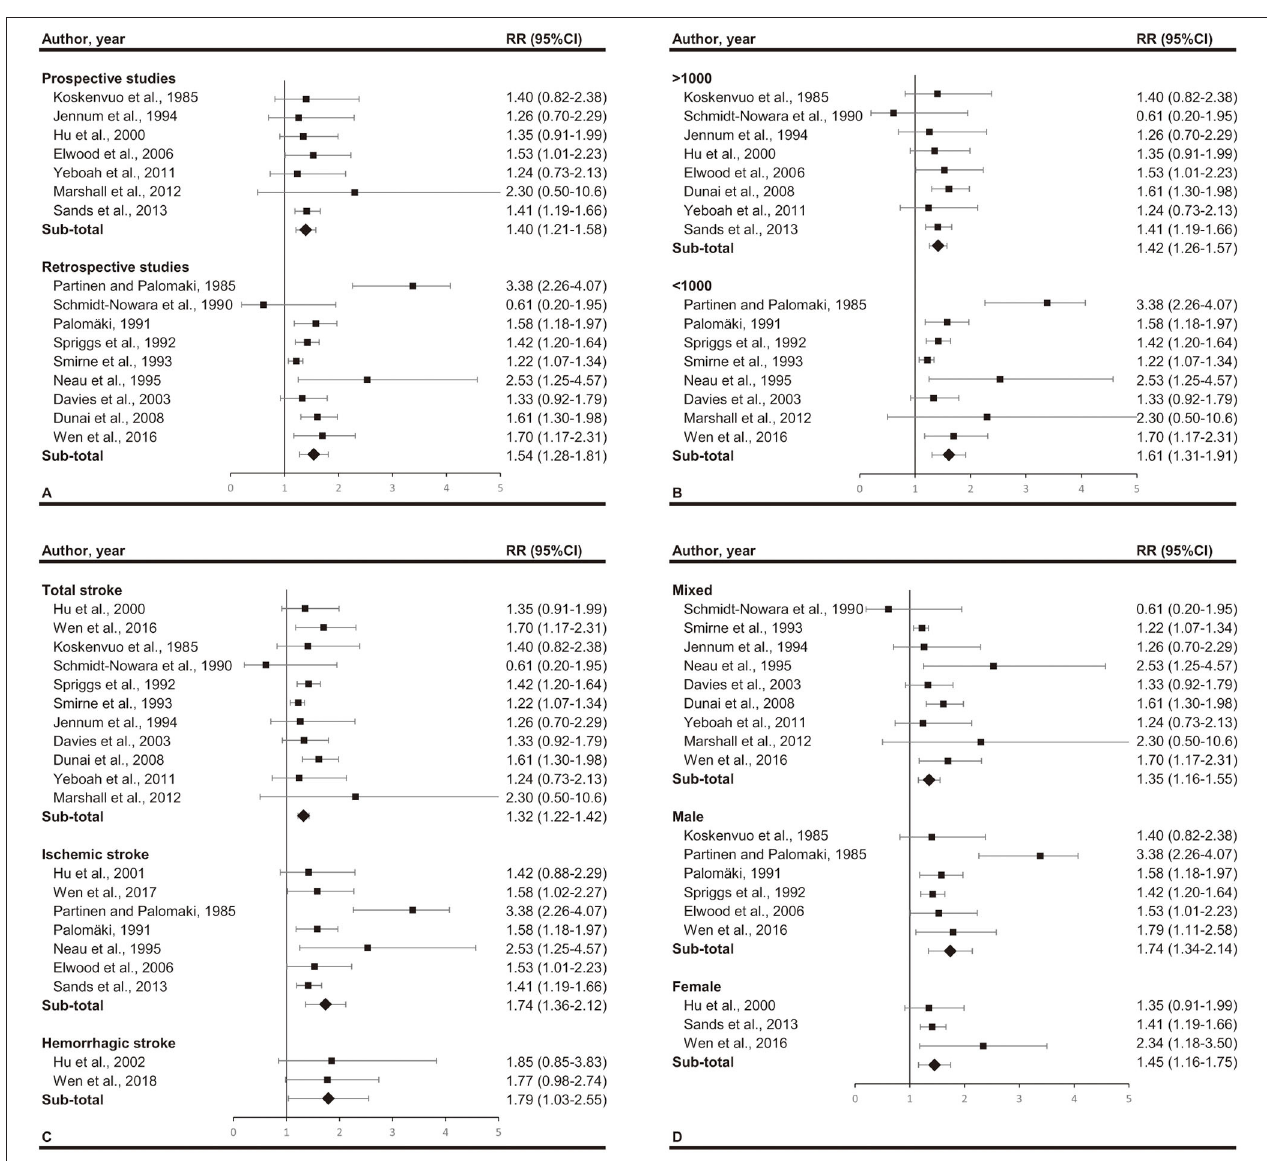
FIGURE 3 | Subgroup analyses by (A) study design (prospective or retrospective), (B) total participants (over 1,000 or not), (C) stroke type (total stroke, ischemic stroke, and hemorrhagic stroke), and (D) gender (mixed, male, and female). Significant association between snoring and stroke exists in all the subgroups.